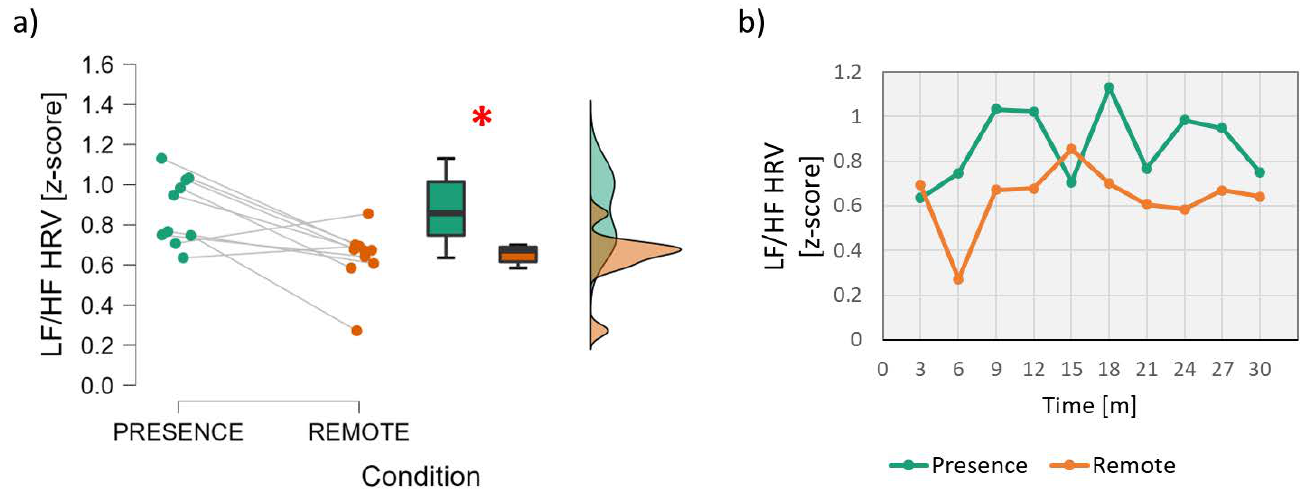
Figure 5. Analysis of the Heart Rate Variability, particularly the ratio between Low and High Frequencies. On the left ( a ), mean and confidence interval (95%) of the distributions related to the two conditions (In-presence and Remote). The red asterisk indicates the presence of a statistically significant effect. On the right ( b ), the dynamics of the HRV parameter averaged across students during the time span of the lesson. The red asterisk indicates the statistically significant ( p < 0.05) result.